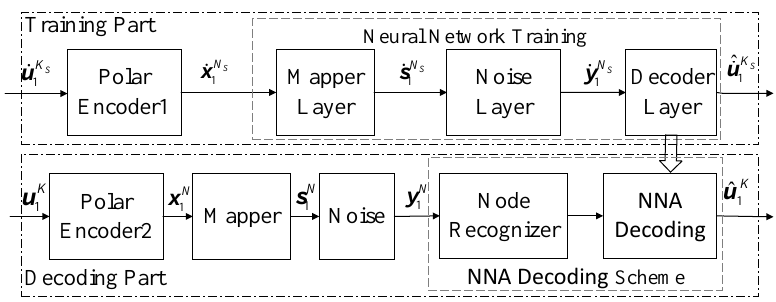
Figure 7. Block diagram of the NNA decoding scheme.